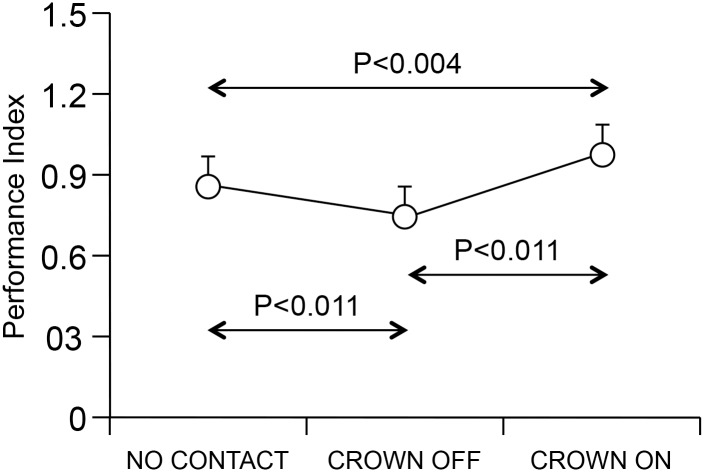
Performance Index in different conditions.The average values of PI have been displayed for each of the three conditions analyzed. The error bars represent standard deviations.